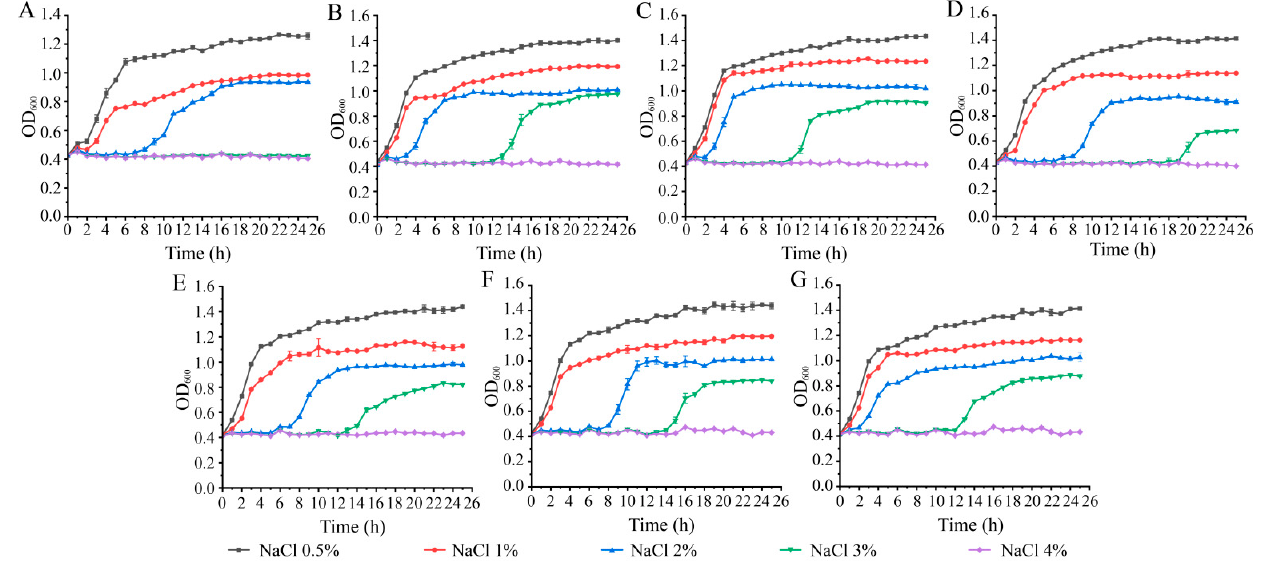
Figure 2. Growth of the K. pneumoniae isolates under different concentrations of NaCl. The isolates were incubated in the TSB (pH 7.5) at 37 °C. ( A – G ): K. pneumoniae 7-5-4, 7-10-14, 7-13-2, 7-17-8, 8-1- 12-1, 8-2-5-4, and 8-2-10-5, respectively.